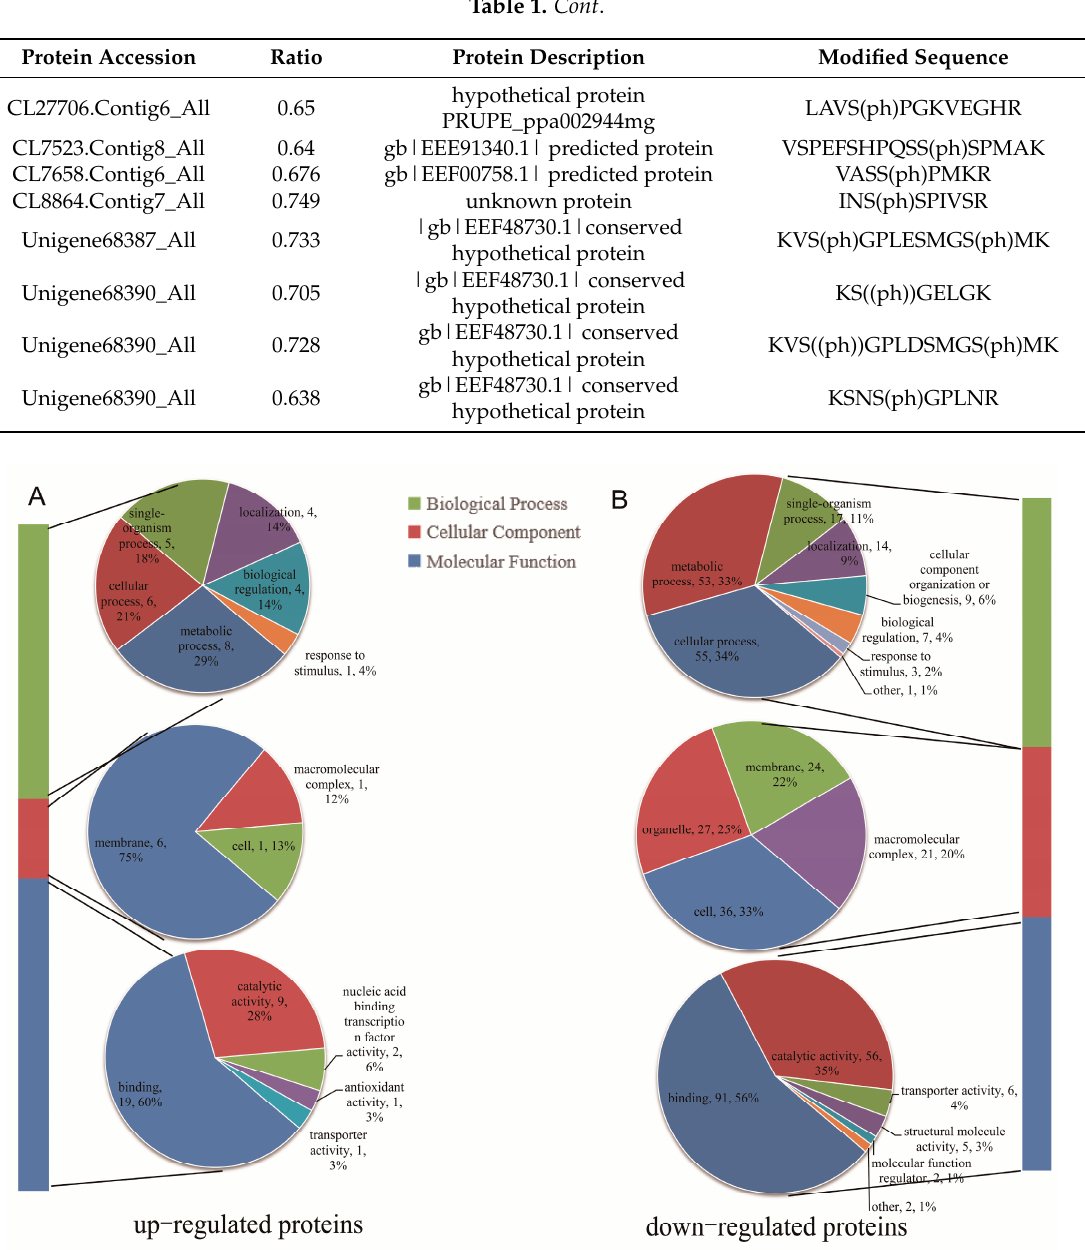
Figure 4. GO annotation analysis of DPPs. Distribution of the upregulated ( A ) and downregulated ( B ) proteins with GO annotation. Different color blocks represented different terms, including cellular component, molecular function, and biological process. Number of the upregulated proteins in each second level term was showed in a pie chart.